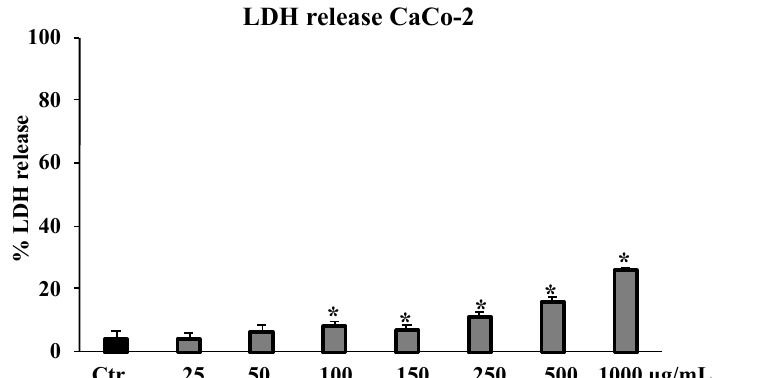
Figure 7. LDH release in untreated CaCo-2 cells (Ctr) and cells treated for 24 h with the total extract (25–1000 µ g/mL). Values are the mean ± S.D. of five experiments in triplicate. Confidence intervals calculated by two-way ANOVA and Tukey post-hoc test: * Significant vs. untreated control cells: p < 0.001.